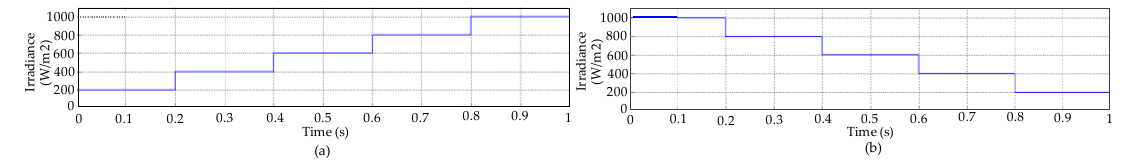
Figure 15. ( a ) Increases in solar irradiance; ( b ) Decreases in solar irradiance.